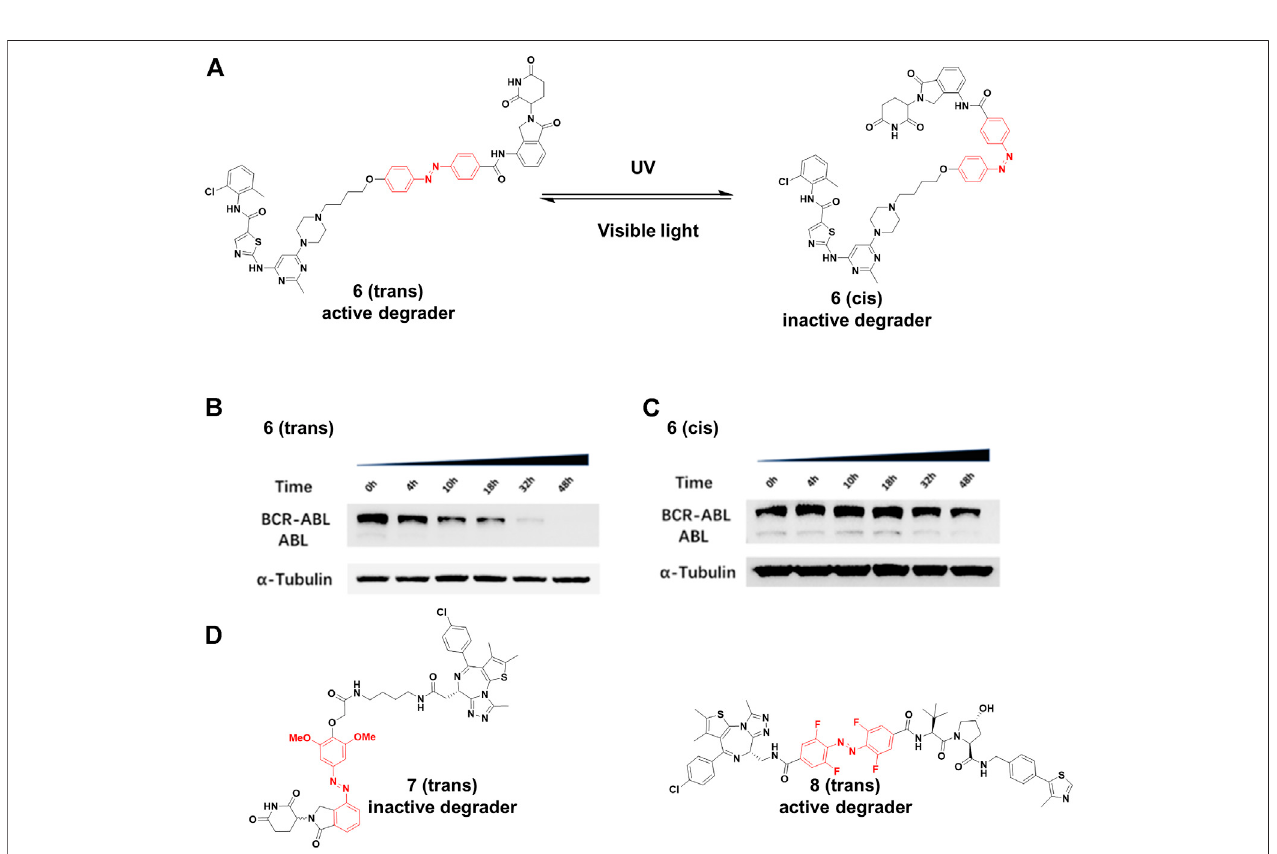
FIGURE 4 | (A) Reversible reaction of 6 upon visible light or UV irradiation. (B) and (C) The time-course Western blot assays of trans and cis- 6 at 250 nM, respectively (Adapted with permission from (Jin et al., 2020). Copyright (2020) American Chemical Society). (D) Chemical structure of photoswitching PROTACs.